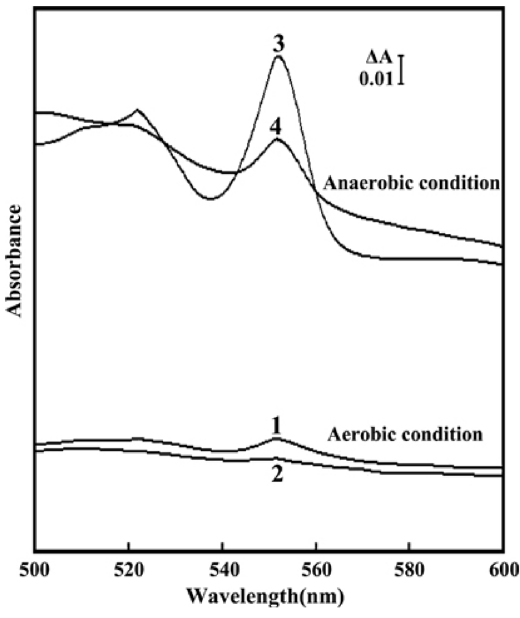
Figure 3. Spectrum analysis of the cytochrome c content of WT and fur mutant strains under aerobic and anaerobic conditions. The reduced-minus-oxidized difference spectra of equal amounts of total protein from the WT and fur mutant strains treated with sodium dithionite were recorded. The absorbance levels of the corresponding untreated strains were set as a control. Line 1 Absorbance of the aerobically grown WT strain. Line 2 Absorbance of the aerobically grown fur mutant strain. Line 3 Absorbance of the anaerobically grown WT strain. Line 4 Absorbance of the anaerobically grown fur mutant